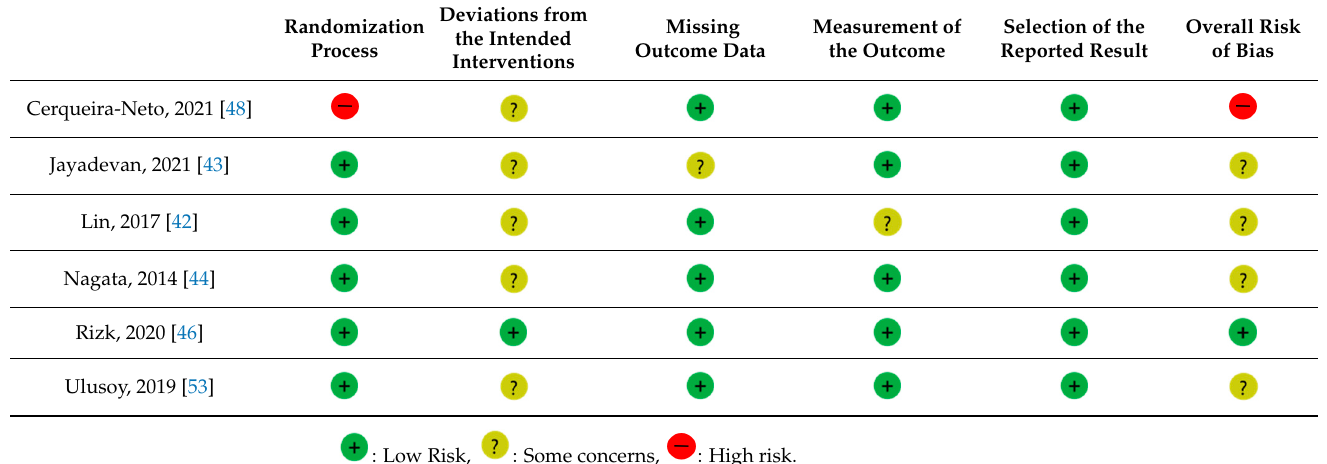
Table 2. Cochrane RoB 2 tool for randomized clinical trials.